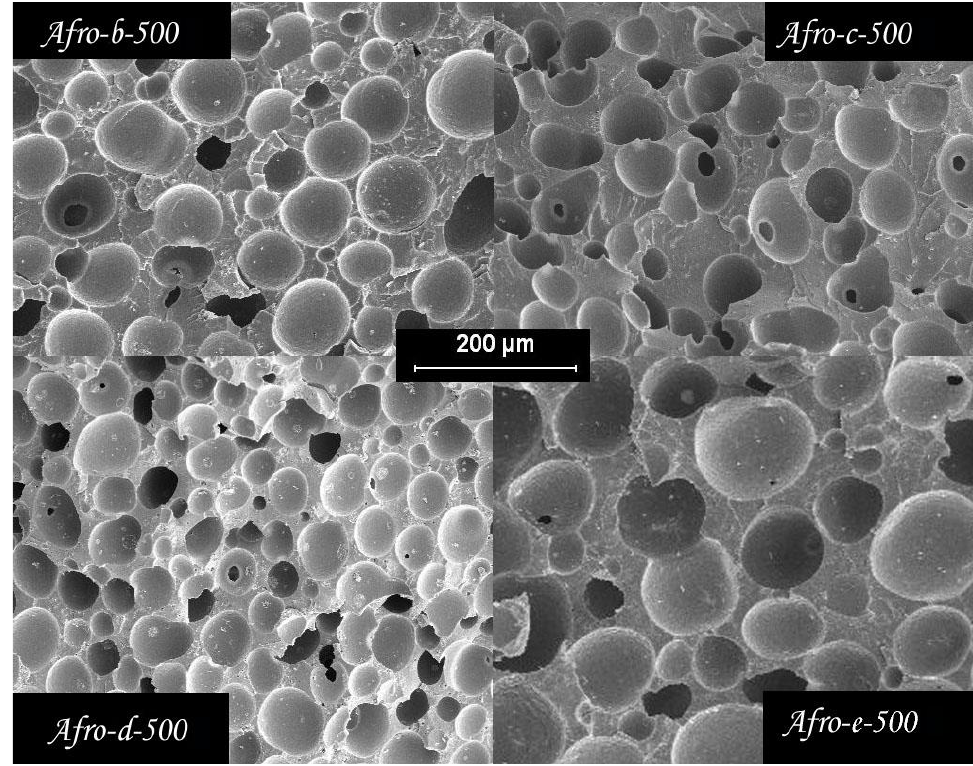
Figure 9. SEM images of the core of four foam samples with relative densities of 0.5 and different amounts of CBA. Table 3. Relative density, cell diameter, cell density, nucleating sites (N-P/cm 3 ) and number of nucleating sites needed to produce a cell (N-P/cell) for the foams of medium relative density 0.5.